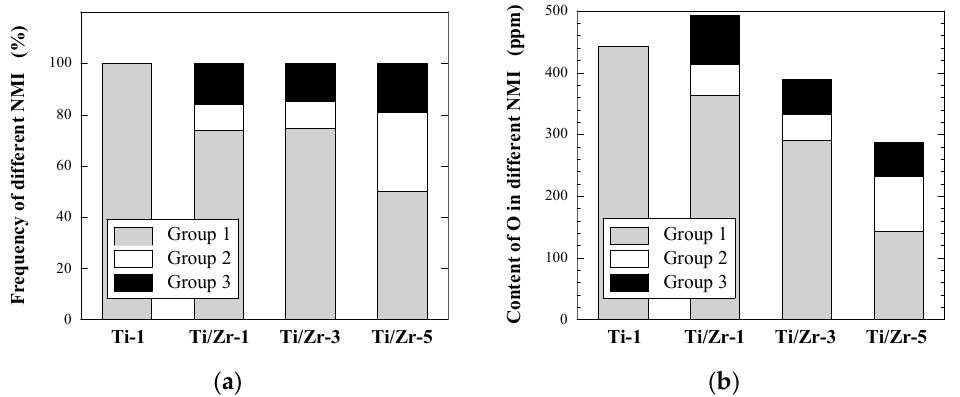
Figure 5. Average frequencies ( a ) and contents of oxygen ( b ) in different NMIs determined by using the FGA method in the Ti and Ti/Zr deoxidation experiments.